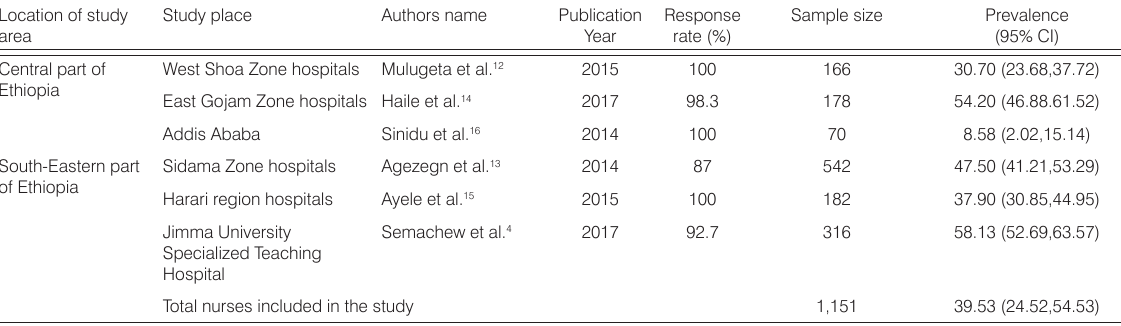
Table 1. Descriptive summary of six studies included in the meta-analysis of the prevalence of nurses’ job satisfaction in